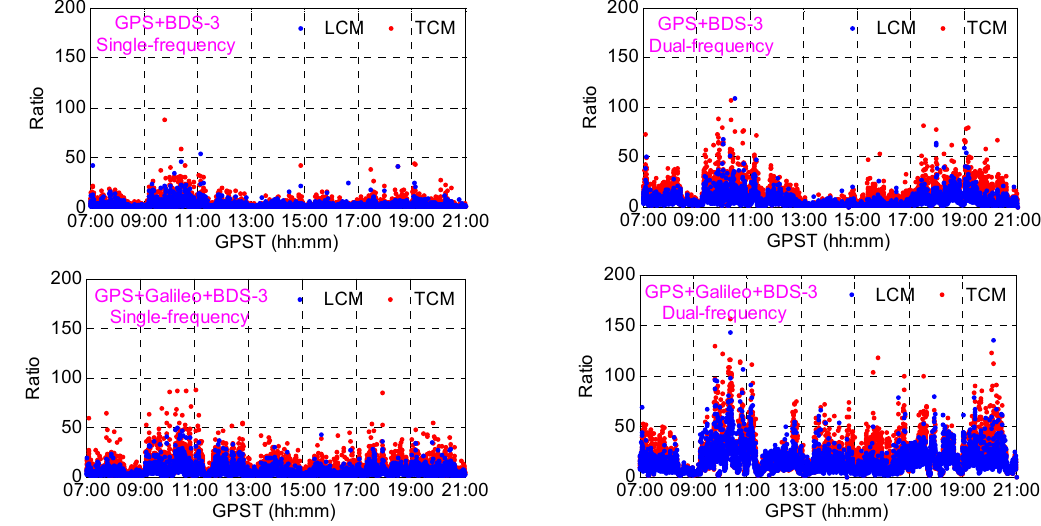
Figure 12. Ratio values for GPS / BDS-3 ( top panels ) and GPS / Galileo / BDS-3 ( bottom panels ) solutions